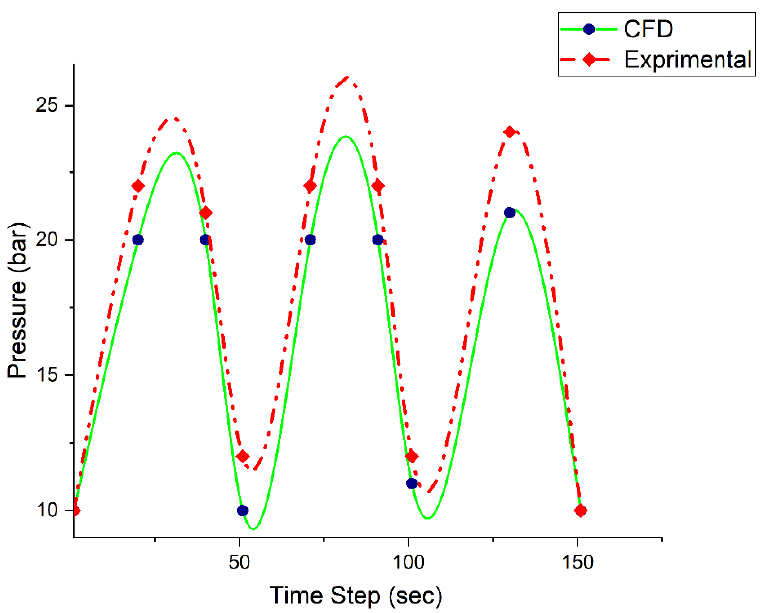
Figure 14. Comparison of pressure at the regenerator inlet of DIPTR.